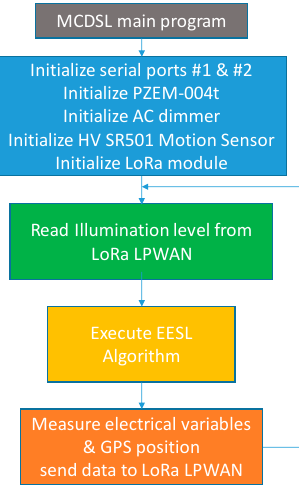
Figure 9. GWLN main program.